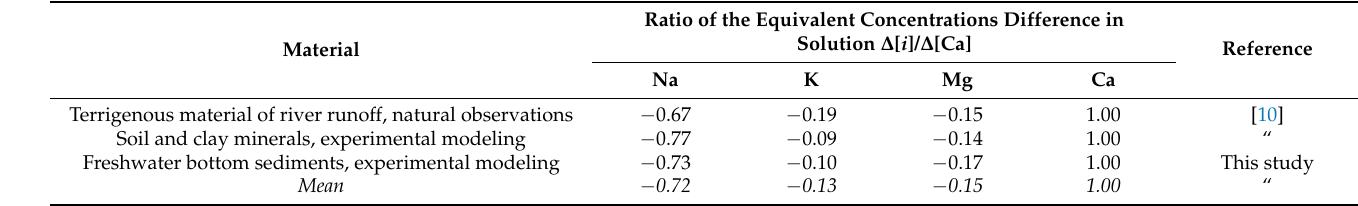
Table 2. Calcium-normalized changes in the composition of the adsorbed complex of terrigenous material during the transition from freshwater to marine